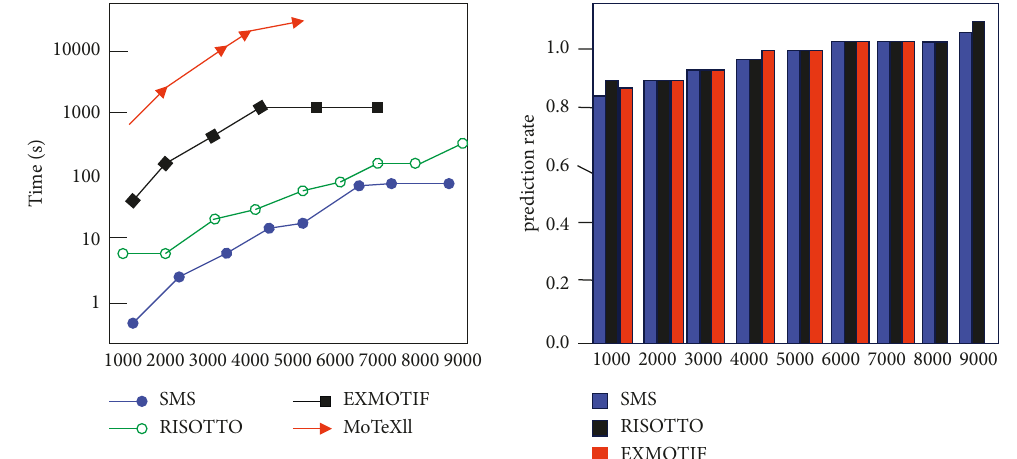
Figure 5: Experimental results at different t .